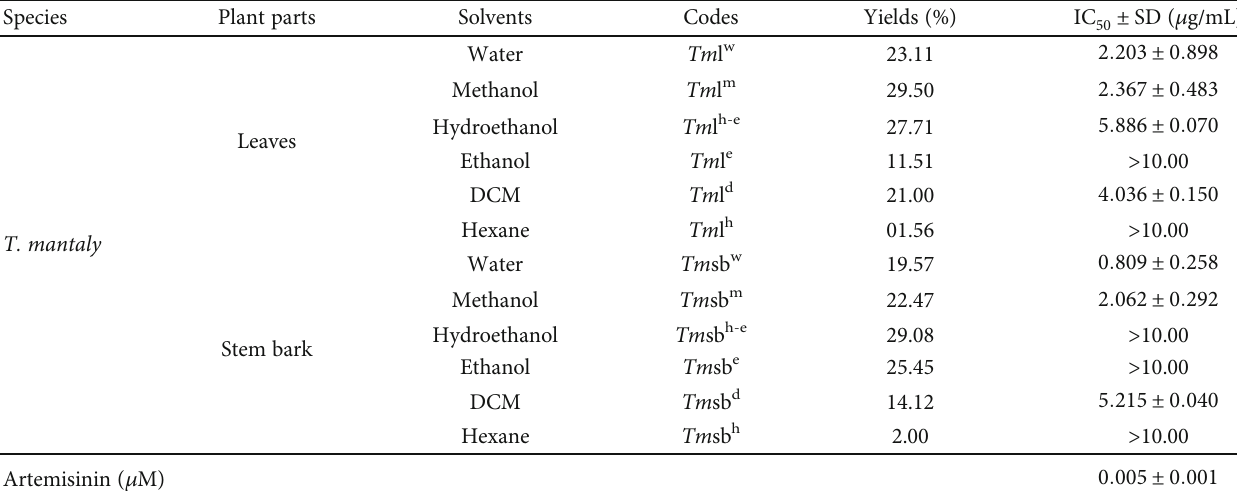
Table 1: Extraction yields and antiplasmodial activity of T. mantaly crude extracts. Species Plant